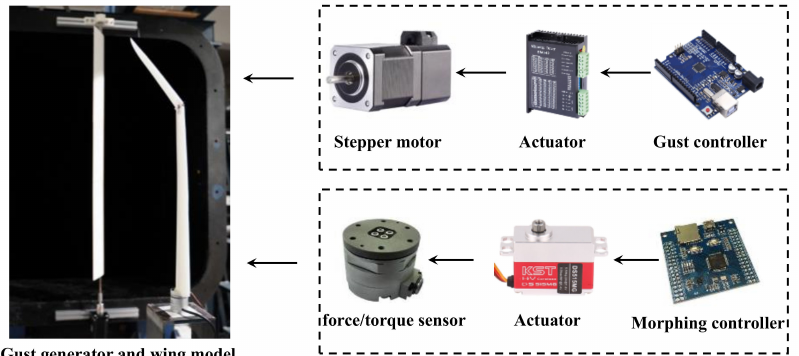
Figure 2. The system of gust generator and control structure